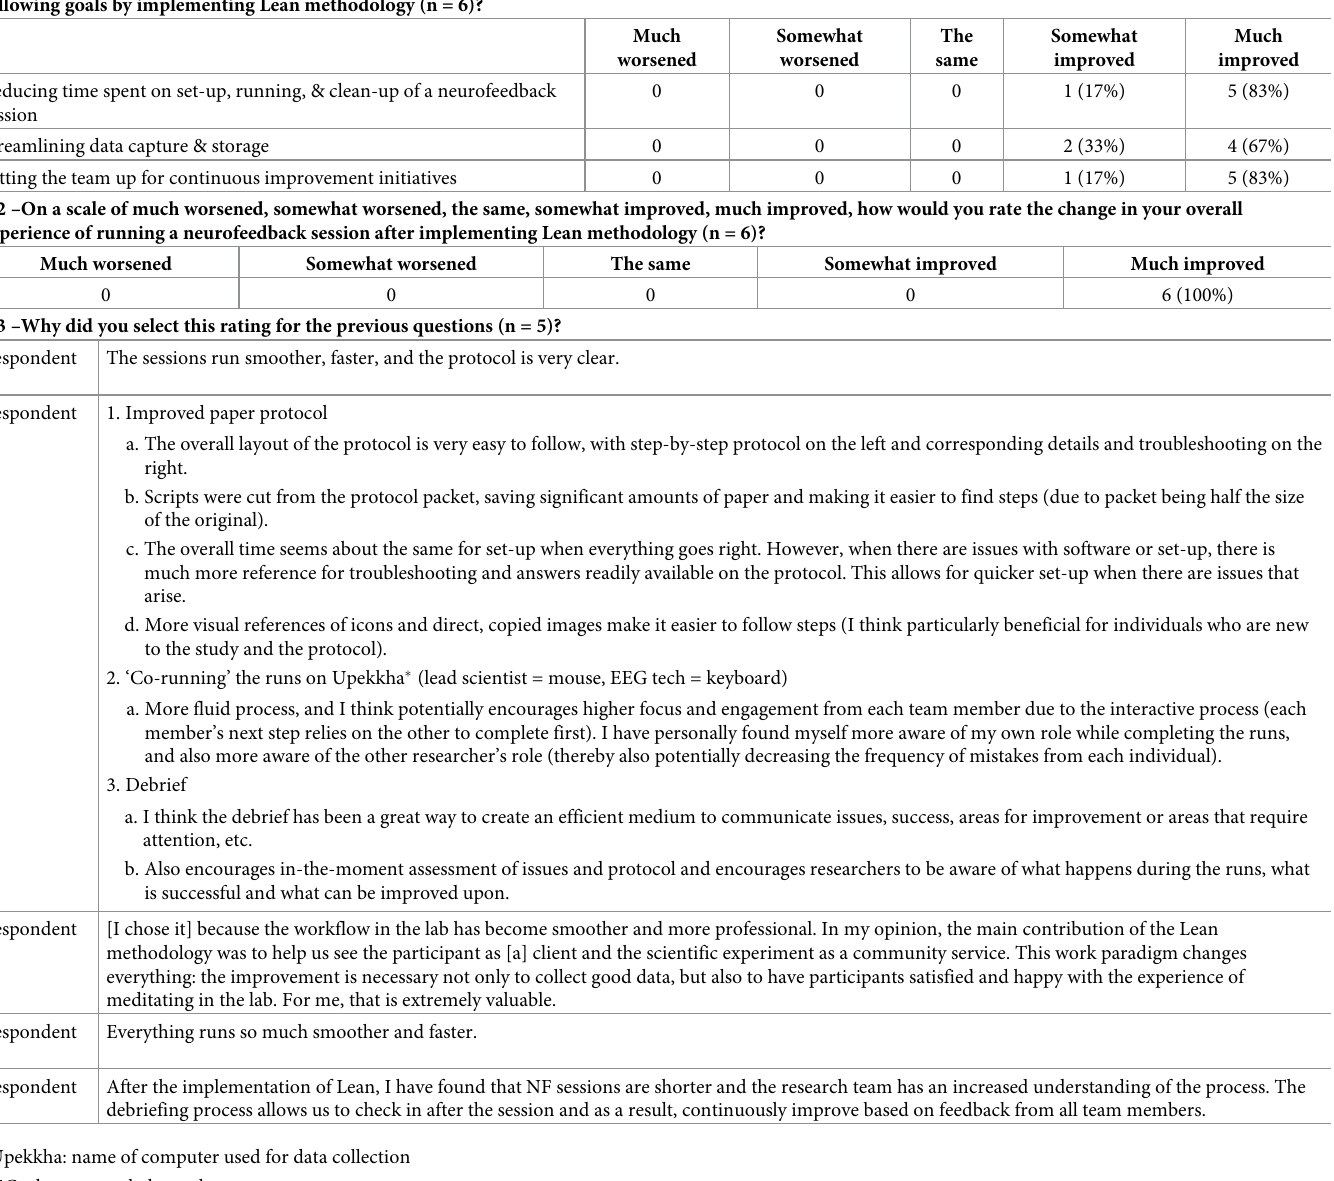
Table 1. Team member responses to anonymous internet